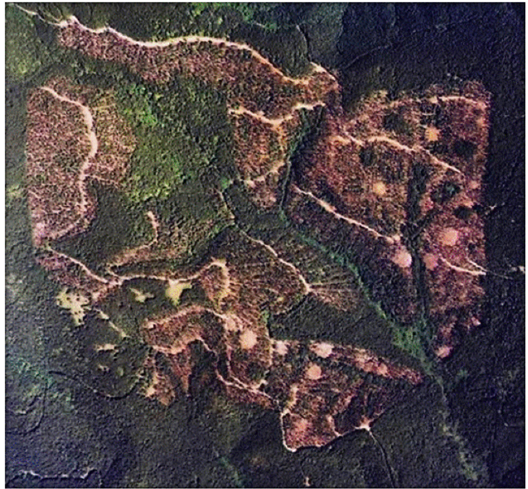
Figure 3. Overview of one replication of the Density Management Study right after installation. Note the range of densities, various gap and leave island sizes, and range of riparian buffer widths. Photo credit: Bureau of Land Management.